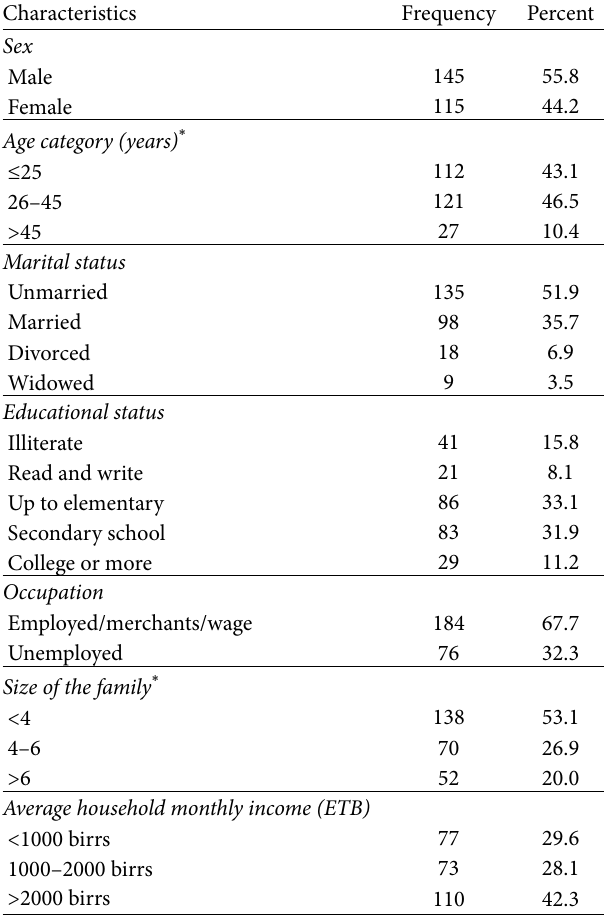
Table 1: Socio-demographic characteristics ( 𝑛 = 260